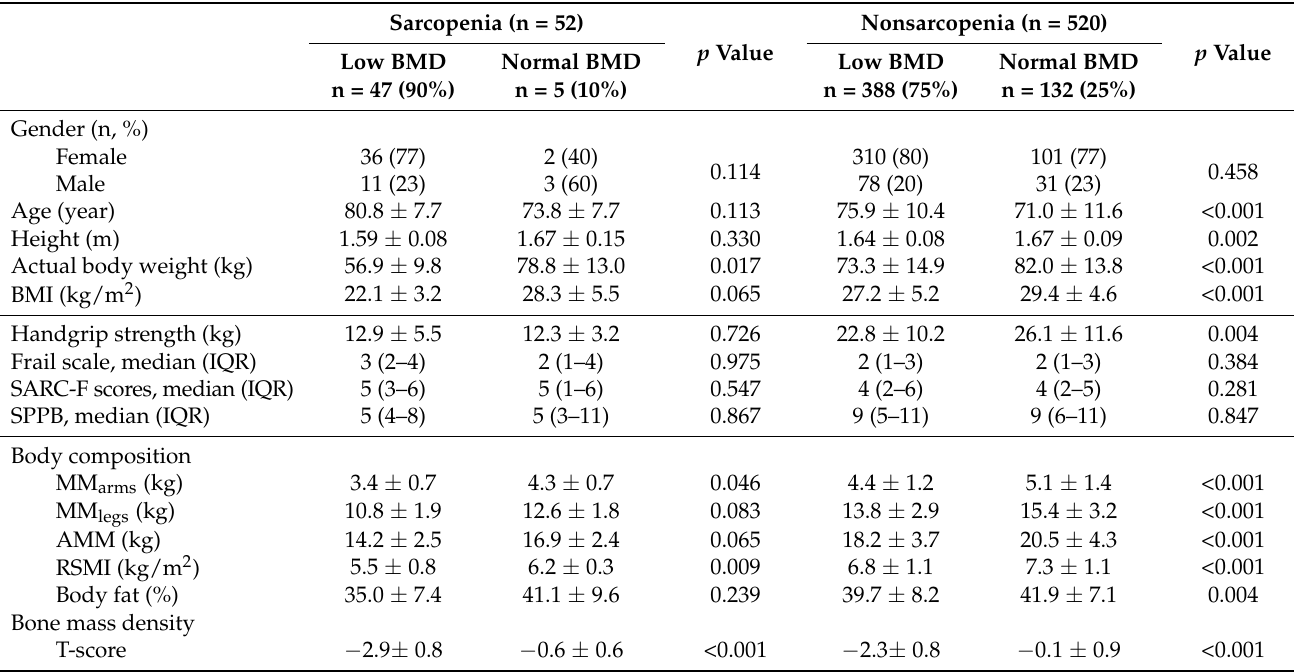
Table 4. Comparison of sarcopenic and nonsarcopenic patients with normal and low